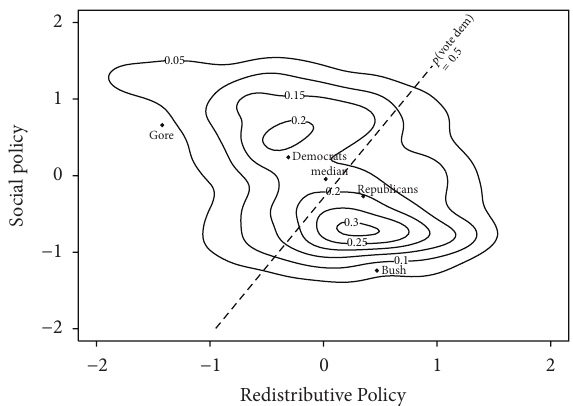
Figure 1: Distribution of voter ideal points and candidate positions in the 2000 US election.